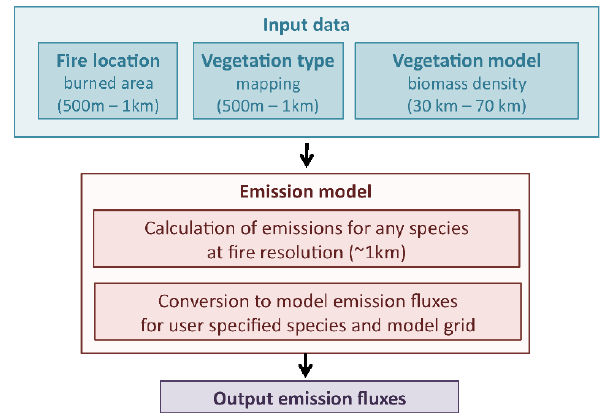
Fig. 1. Schematic representation of the general structure of the emissions’ evaluation with the APIFLAME model.